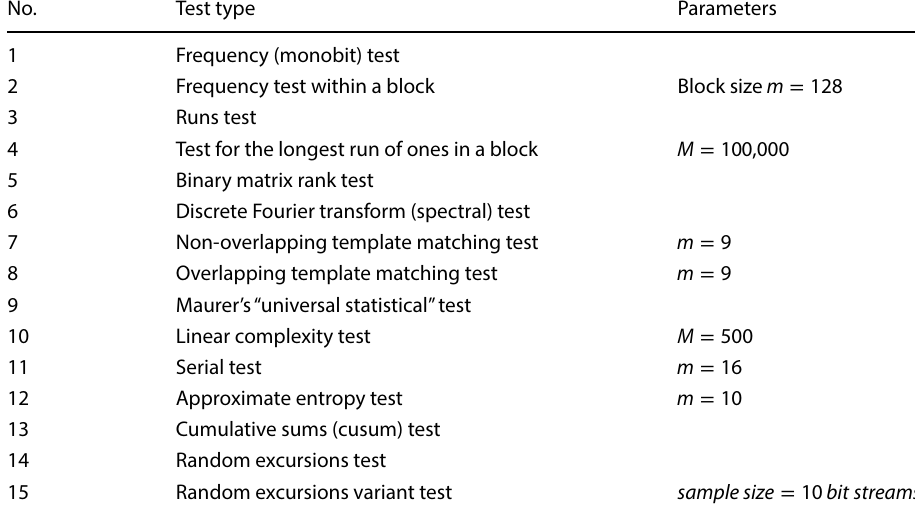
Table 3 Fifteen randomness tests from NIST 800-22 Test Suite (version 2.1.2) and the parameters used in this